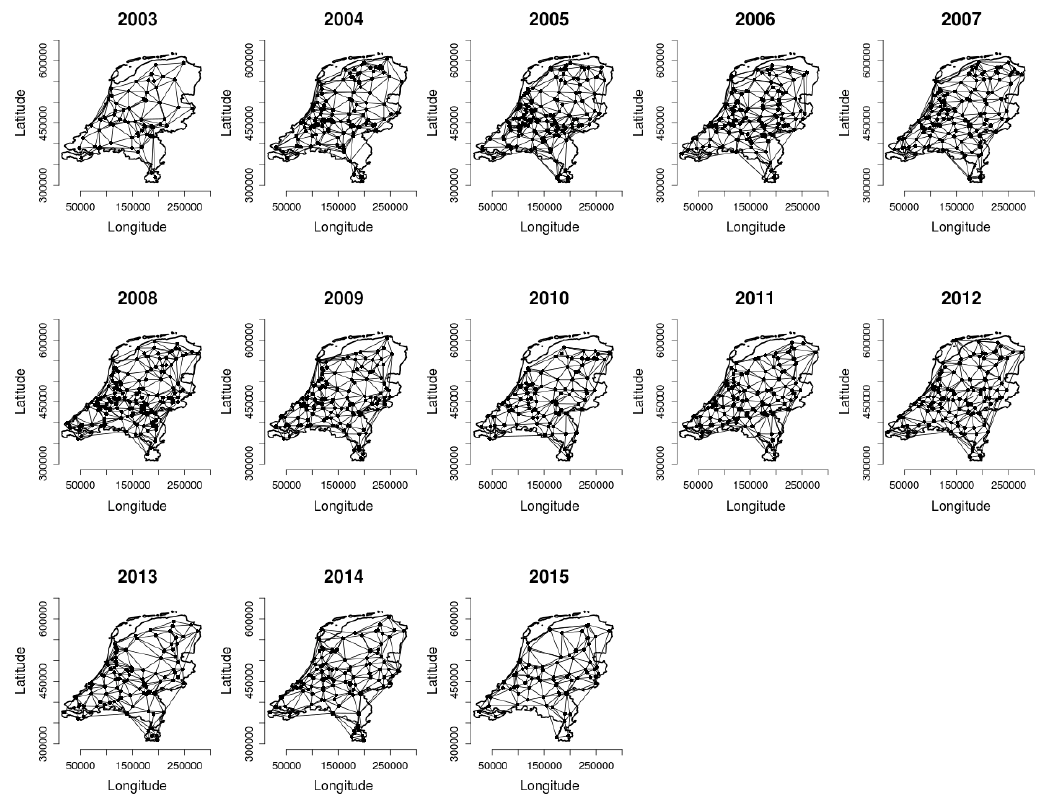
Figure A2. Annual graphs for cow parsley flowering onset observations. The graphs were made using a Delaunay triangulation and edges longer than 100 km were pruned.